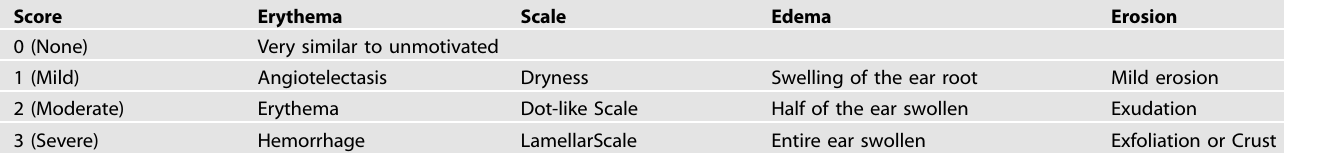
Table 3. Measurement of Dermatitis